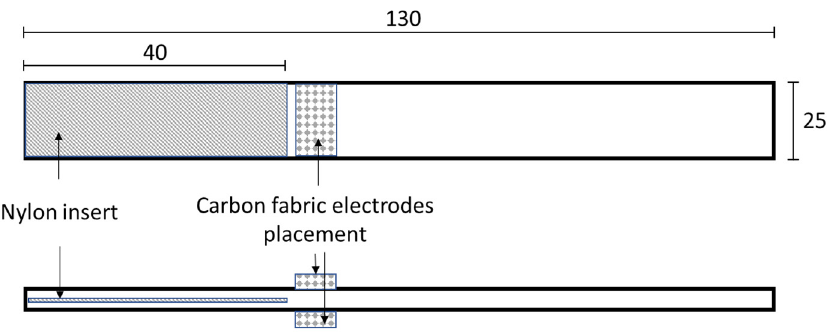
Figure 1. Schematic illustration of the attached carbon fabric electrodes setup on mode-II geometry and the dimensions in mm.